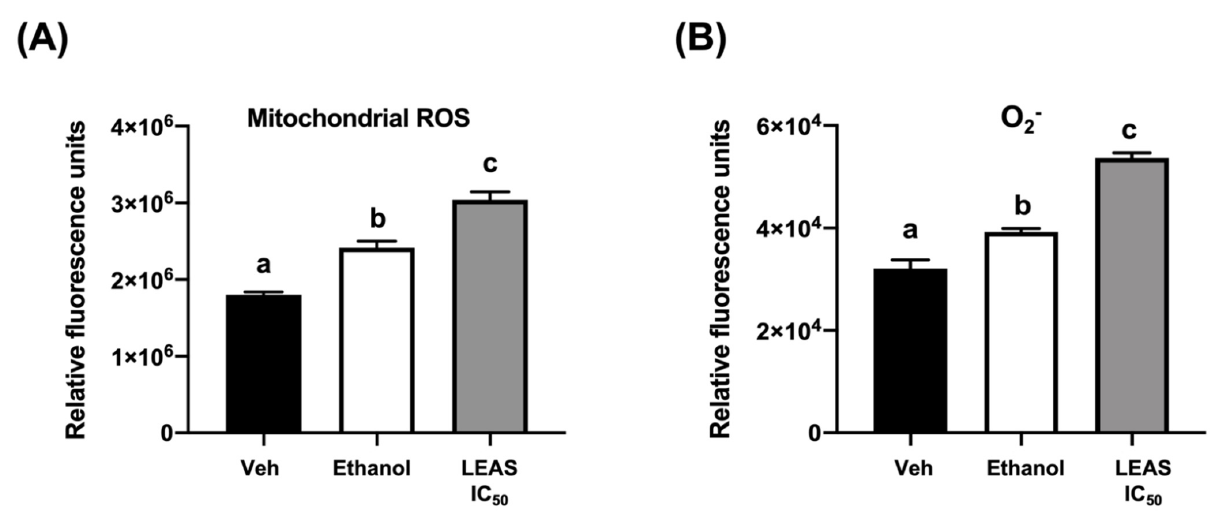
Figure 6. LEAS increased the production of ROS in D-17 cells. The production of mitochondrial ROS ( A ) and superoxide anion ( B ) were assessed by flow cytometry using the dyes DHE (5 µM) and DHR (10 µM), respectively. Cells were treated for 48 h with LEAS IC 50 (15.5 µg/mL), vehicle (DMSO 0.1%), or ethanol (12%) as a positive control. The graphic shows fold-change values for each treatment. Each bar shows the mean of triplicates ± SE of two independent experiments. Different letters indicate statistically significant differences in relation to the vehicle ( p < 0.05).